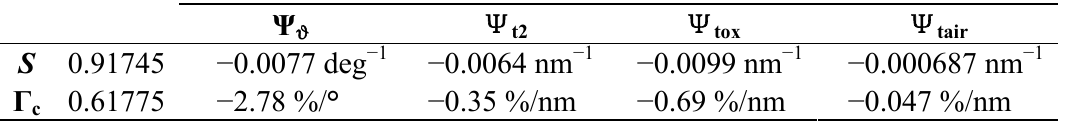
(absorption sensing) c = max